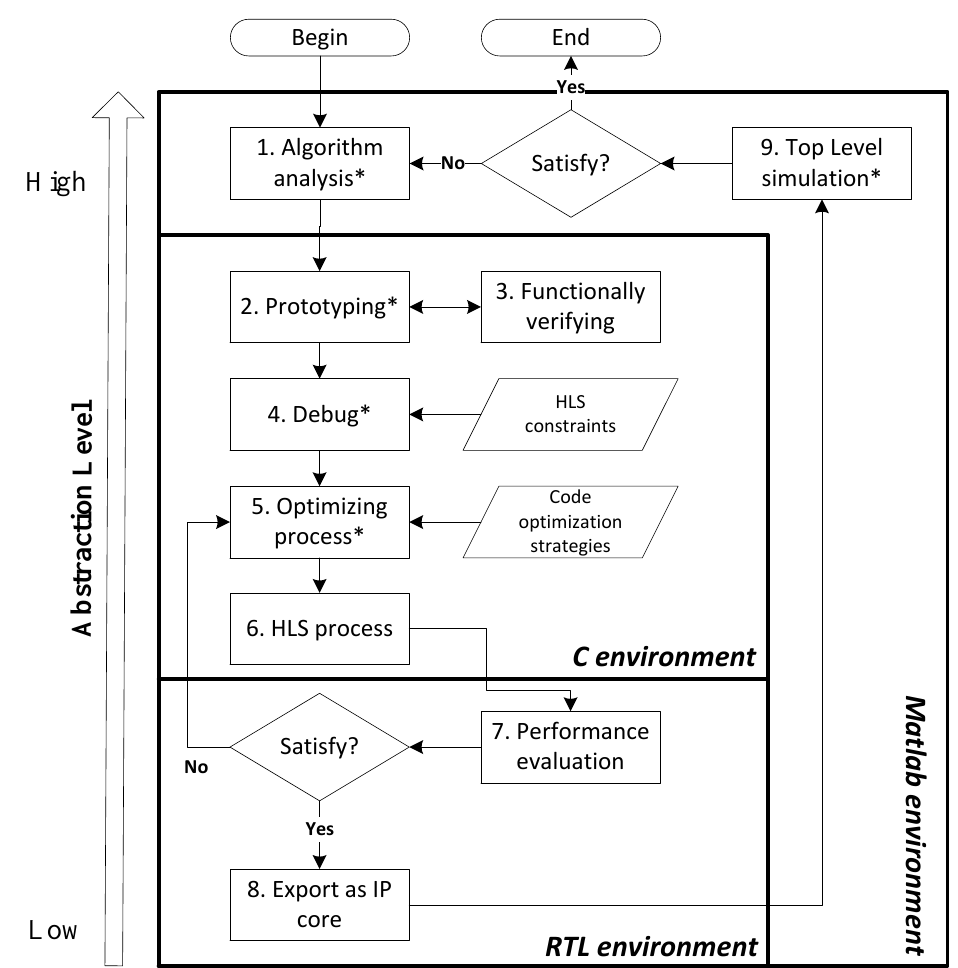
Figure 2. High-Level Synthesis (HLS)-based design flow: “ * ” refers to the manual-necessary